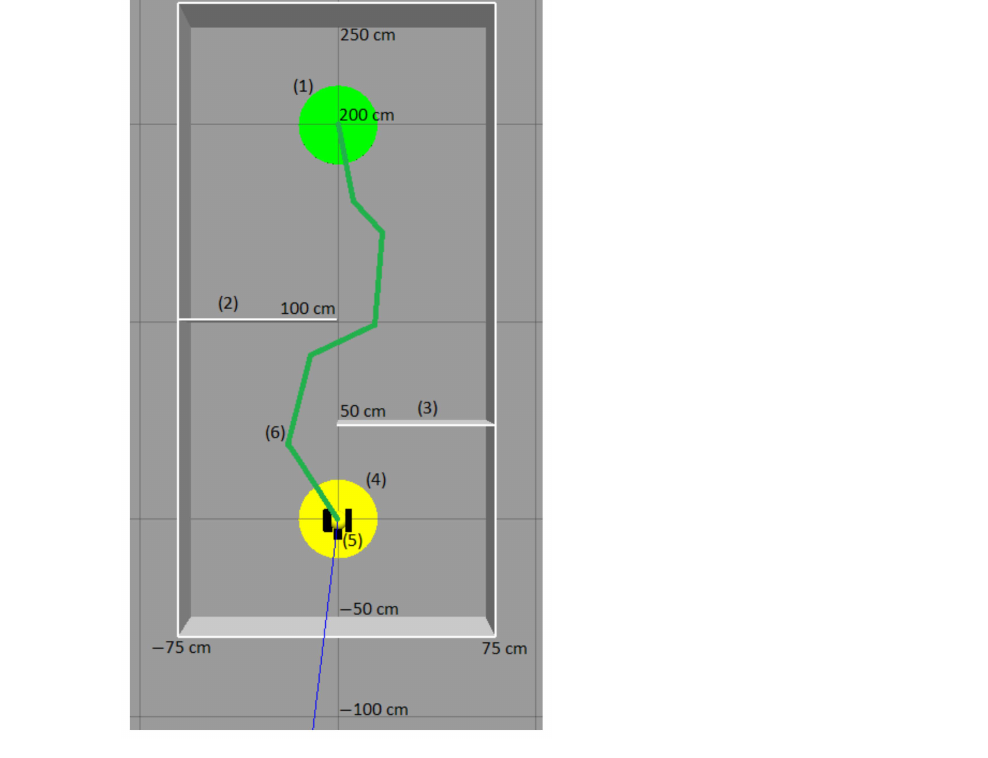
Figure 18. Trajectory of the maze with two simulated obstacles: (1) goal, (2,3) obstacles, (4) home, (5) robot, and (6) trajectory.